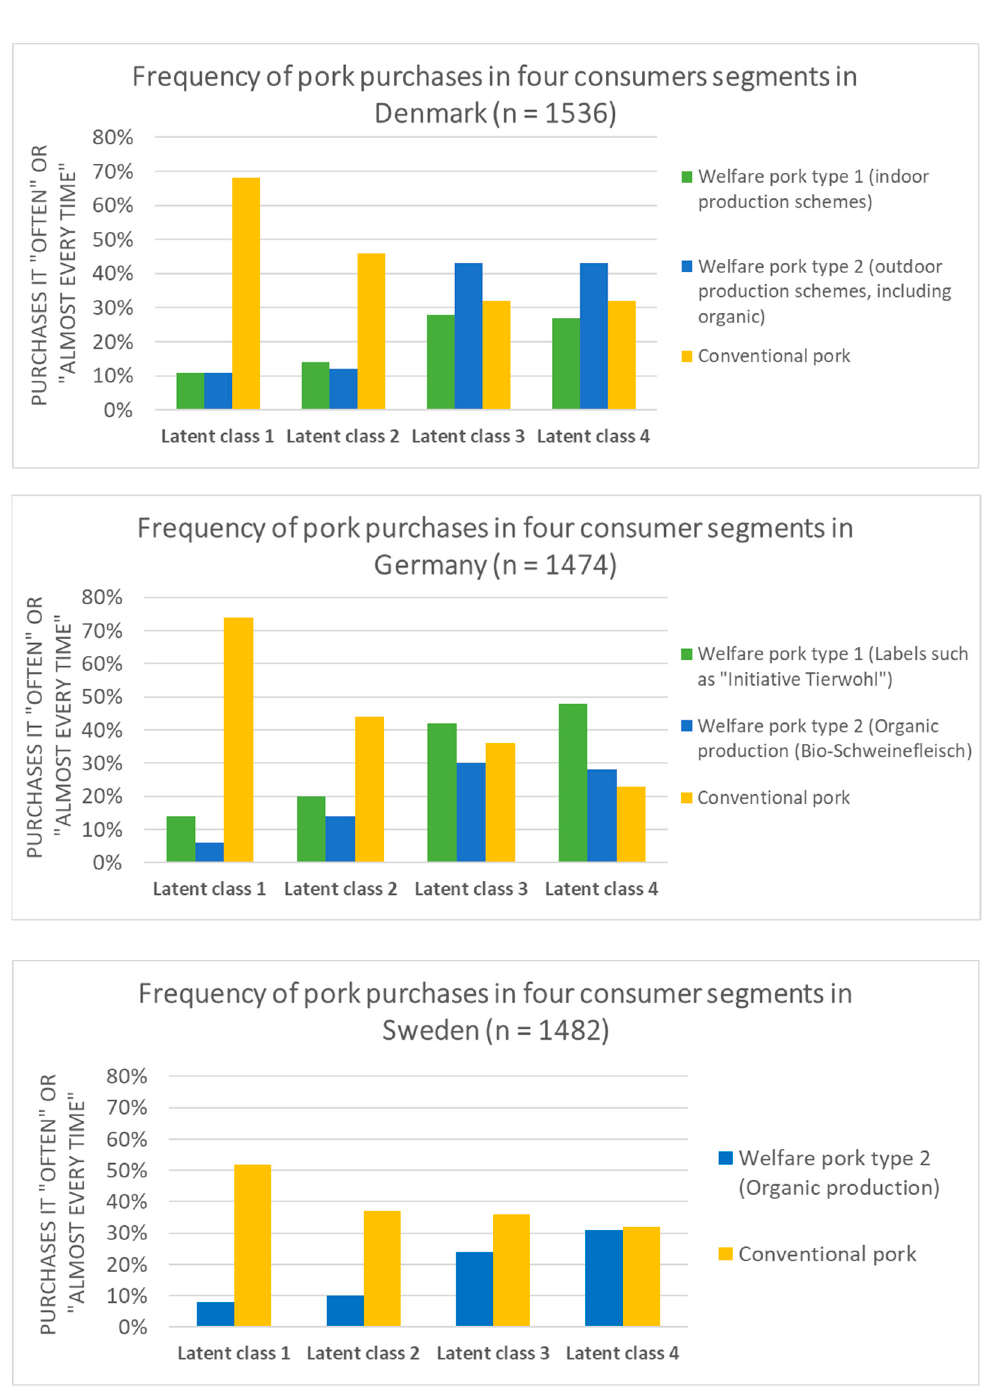
Figure 1. Frequency of purchase of three types of pork in four subpopulations in Denmark, Germany, and Sweden.